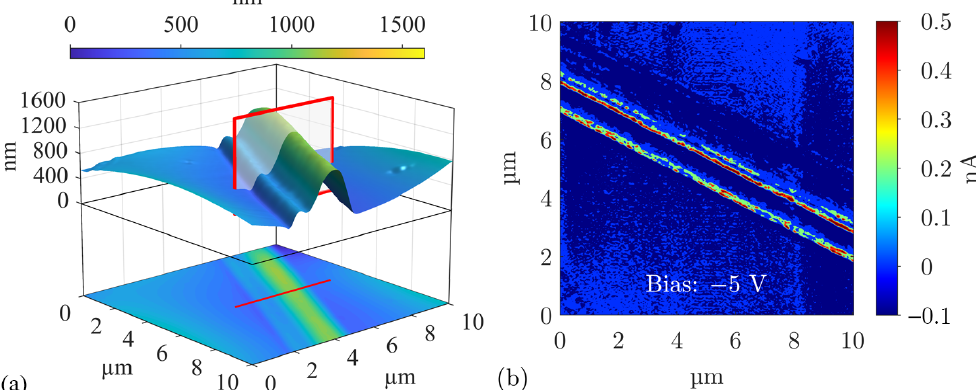
Figure 6. ( a ) Fiber similar in shape to the one that was acquired by SEM and mentioned in Figure 5a. The same fiber is also measured using the ( b ) PFM method, where the authors confirm the different orientation of the domains with a bias of − 5 V